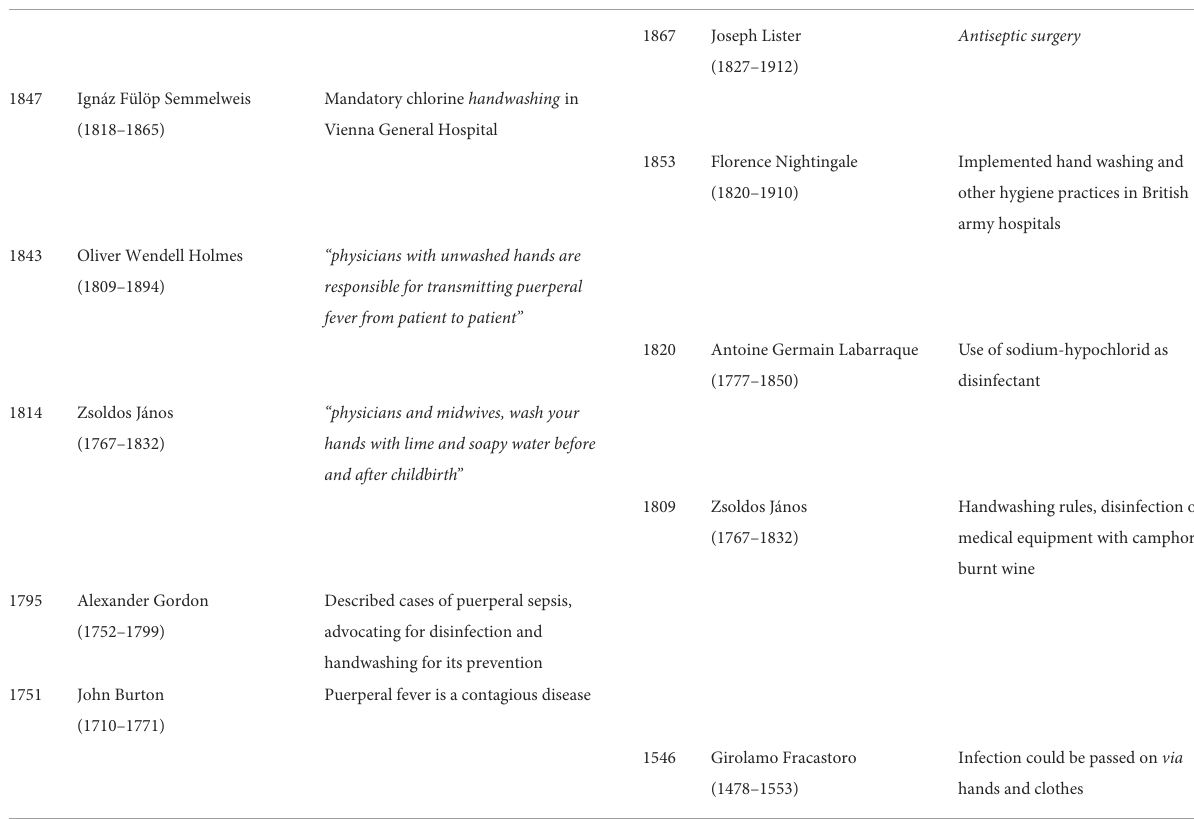
TABLE 1 Landmark contributions in hand hygiene and infection control from 1546 to